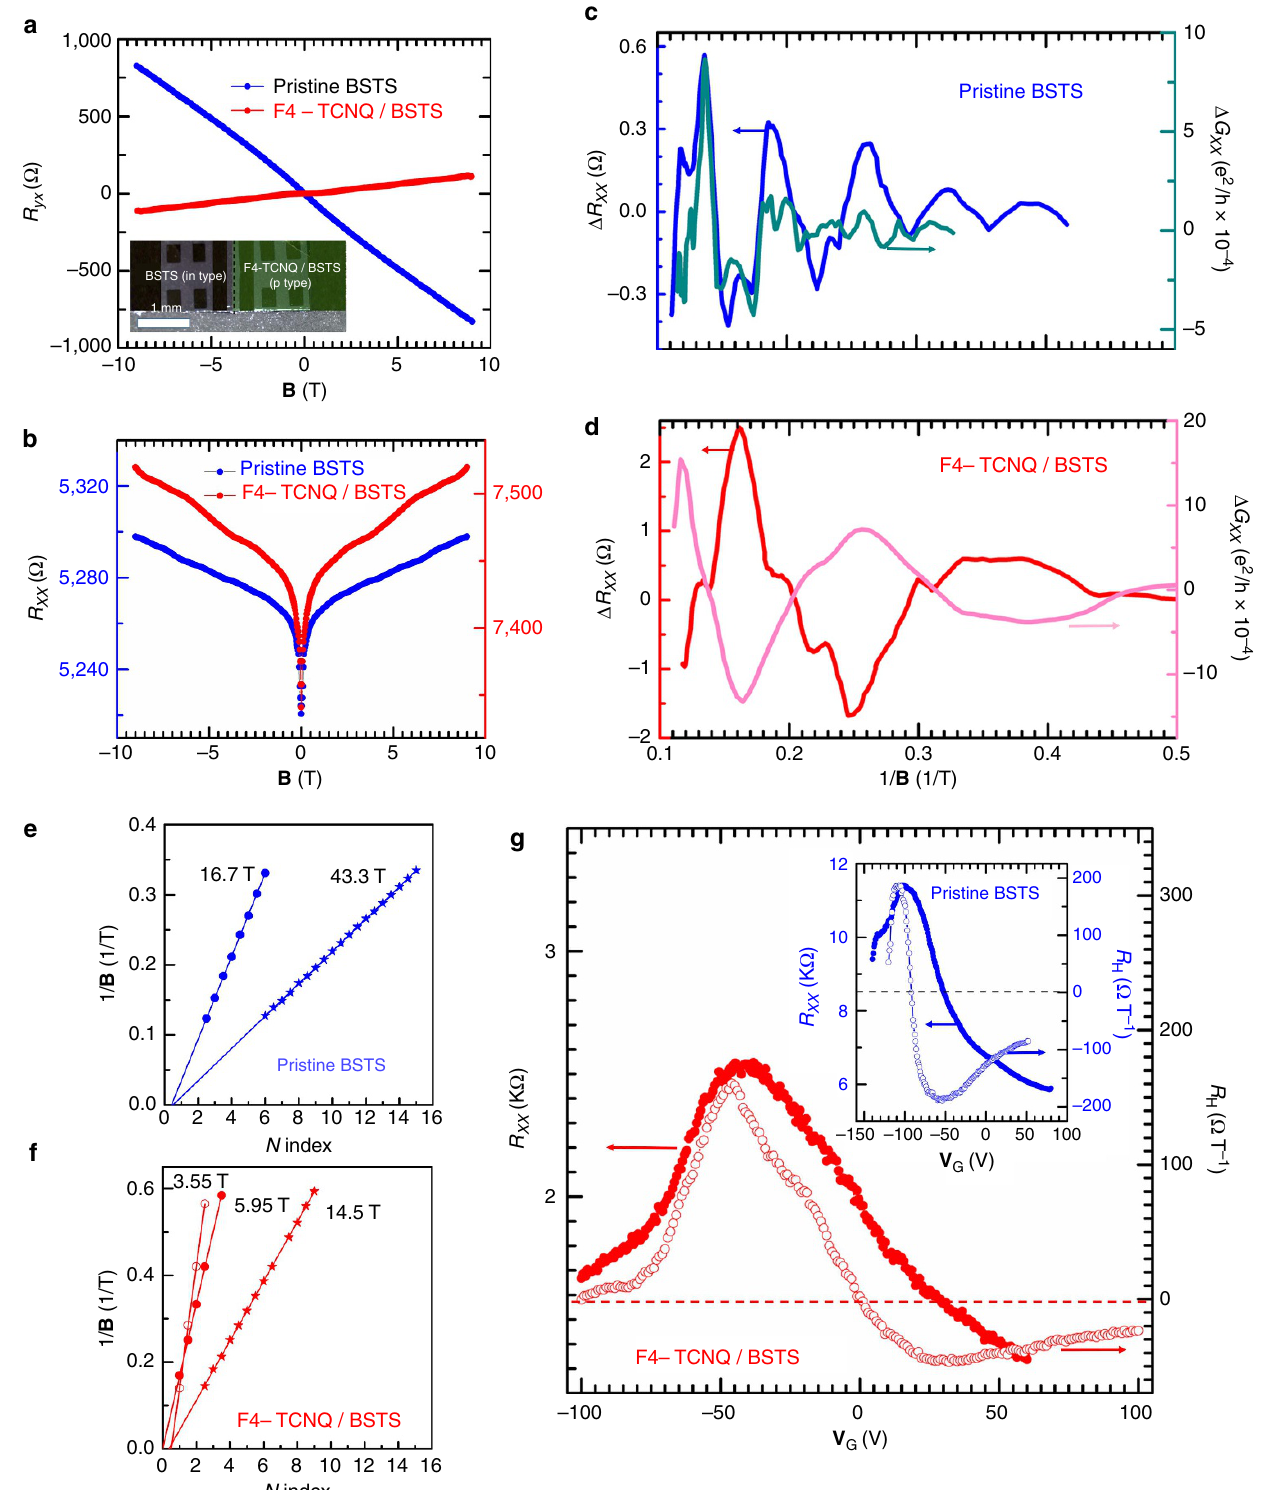
Figure 3 | Electric transport of BSTS and F4-TCNQ/BSTS device. ( a , b ) Magnetic field ( B ) dependence of transverse and longitudinal resistance ( R yx and R xx ) at 2K for pristine BSTS and F4-TCNQ/BSTS on mica. Inset of a shows a microscope view of pristine BSTS and F4-TCNQ/BSTS device. ( c , d ) 1/ B dependence of the oscillatory parts of longitudinal resistance ( D R xx ) and longitudinal conductance ( D G xx ) at 2K. ( e , f ) A Landau level fan diagram plot, where the valley (the peak) in D G xx indicates as an integer n (a half integer n þ 1/2). ( g ) Gate voltage ( V G ) dependence of R xx and Hall coefficient ( R H ) calculated from R yx at B ¼ ± 9T for a F4-TCNQ/BSTS bottom gate field effect transistor (FET) prepared on a SiO 2 /Si substrate. Inset shows V G dependence of R xx and R H for a device for pristine